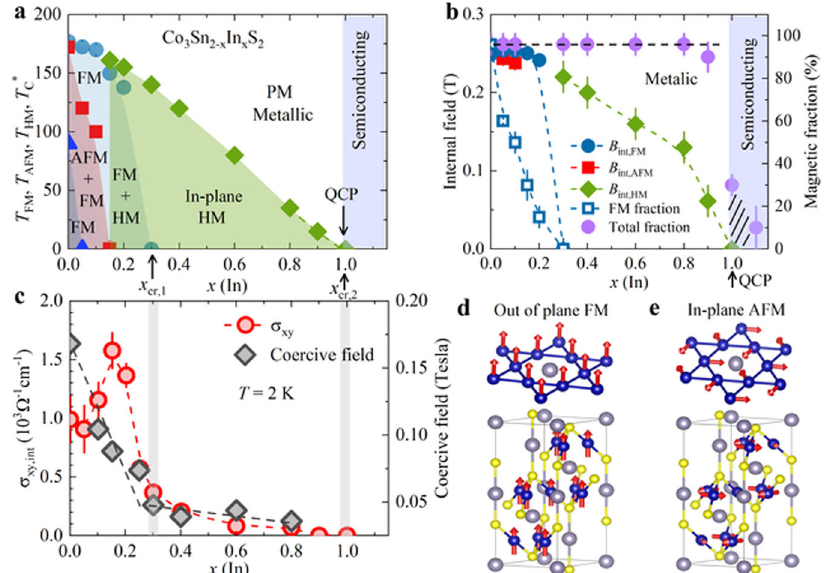
Fig. 5 (Color online) Phase diagrams for CoSn 2 − x In x S 2 . a Temperature-doping phase diagram. T FM , T AFM and T HM indicates the FM, AFM, and denotes the temperature below which only the FM state exists. b The doping dependence of the putative HM transition temperatures. T (cid:1) C base-temperature value of the internal internal magnetic fi elds, the FM ordered fraction and the total magnetic fraction. The black dashed line marks the region with weak disordered magnetic response. c The In-doping dependence of the in-plane anomalous Hall conductivity σ xy,int and the coercive fi eld at T = 2 K. d , e Spin structures of Co 3 Sn 2 S 2 , i.e., the c -axis aligned FM structure (R-3m 0 subgroup) and the in-plane AFM structure (R-3m subgroup). HM state is most likely a helical variation of the in-plane AFM